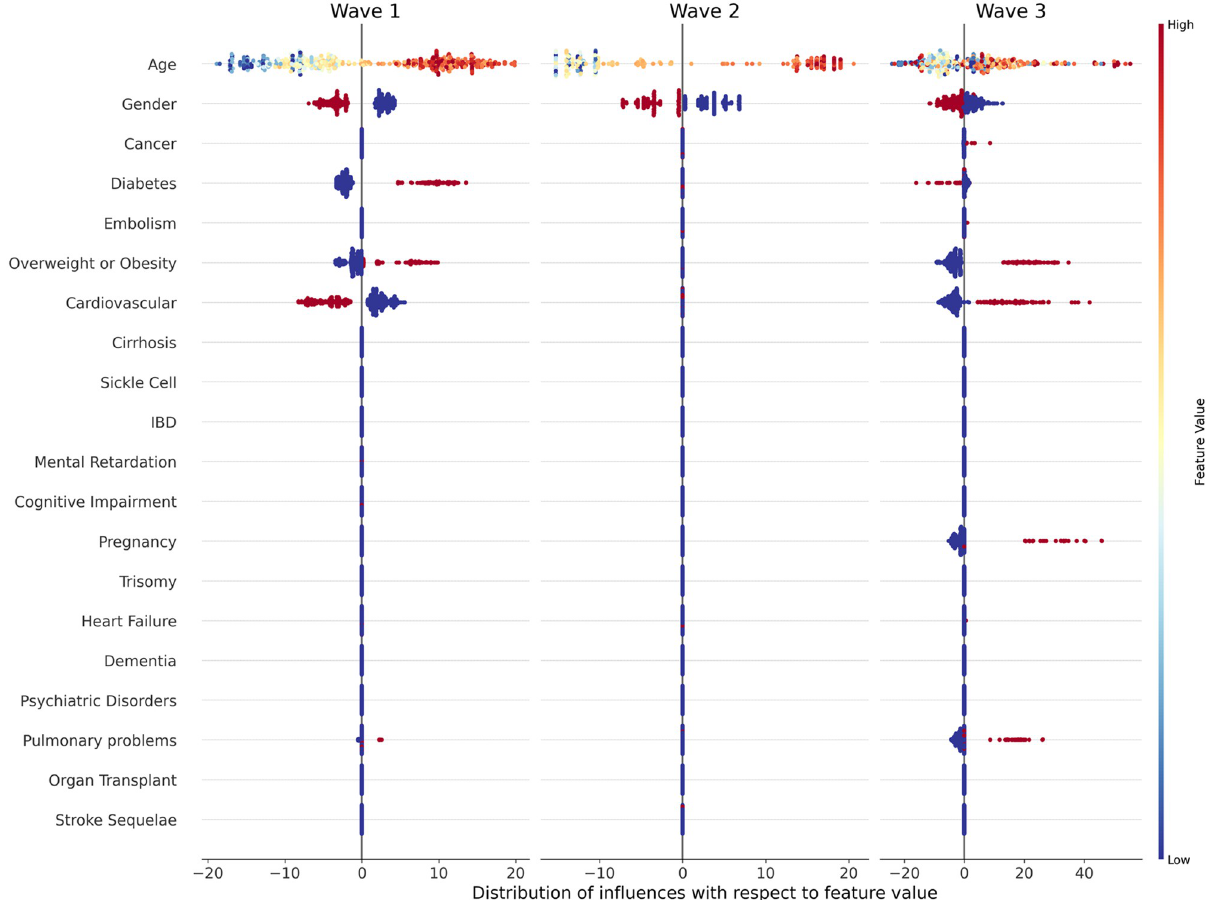
Fig 3. Distribution graph of influence with respect to feature value for each feature per wave (best viewed in color). Each dot represents a particular patient from the dataset, with feature names on the y-axis and influence values on the x-axis. A negative influence can thus be considered as a protective factor since it decreased the probability of being in a severe state, whereas a positive influence can be considered as a risk factor. The initial value is represented by the color of the point, through the colormap indicated on the far right of the figure. A low initial value (for example a young age) is indicated by a blue point, while a high initial value (an old age) would be a red one. Gender value is 0 for men (blue dots) and 1 for women (red dots) while Comorbidity value is 0 for the absence (blue) and 1 for the presence (red).